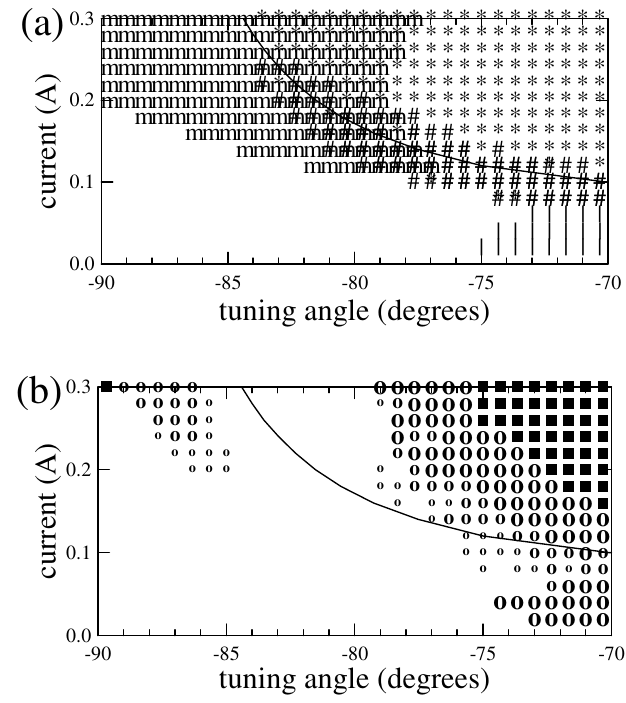
FIG. 9. Modeling for the new MAX-II 100-MHz/500-MHz rf system, with microwave instability from the broadband imped- =p j (cid:2) 5 : 7 (cid:3) . A solid curve shows the parameters for ance j Z p optimal bunch lengthening. (a) Analytic predictions. m: micro- wave instability; |: coupled-dipole Robinson instability; *: coupled-quadrupole Robinson instability; #: fast dipole- quadrupole mode-coupling Robinson instability. (b) Results of 500 000-turn simulations of 120 000 macroparticles. o: mild instability, where the energy spread exceeds its natural value by (10–30)%; o : moderate instability, where the energy spread has increased by (30–100)%; O : strong instability, where the energy spread has increased more than 100%; (cid:1) : lost macro-